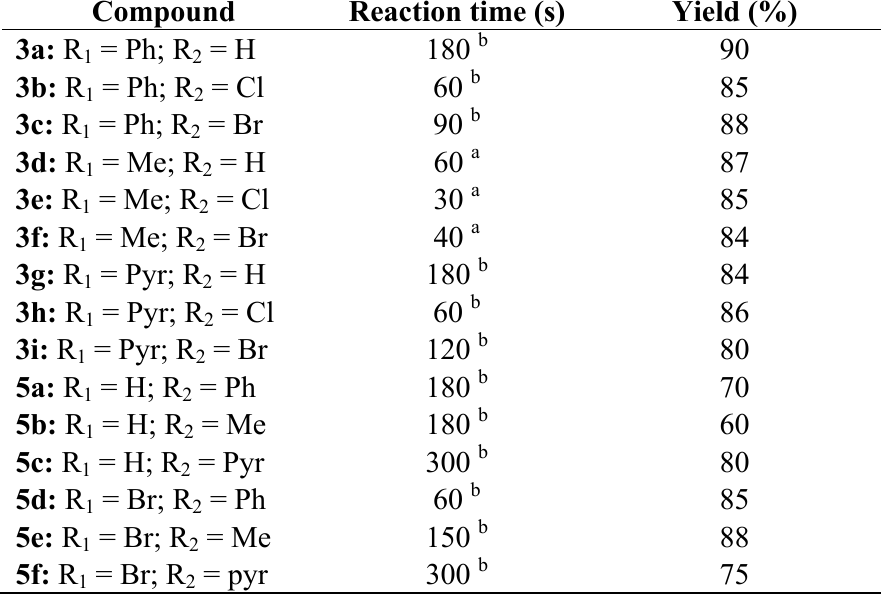
Table 1. Reaction times and yields in the synthesis of compounds 3a – i and 5a – f . Compound Reaction time (s) Yield